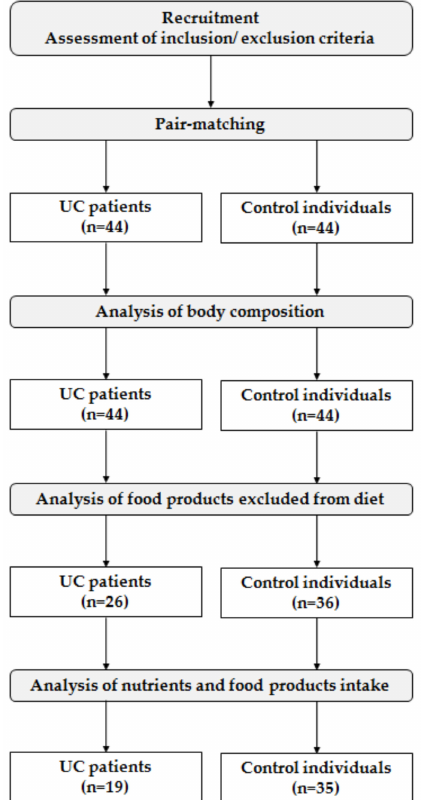
Figure 1. Study design and number of